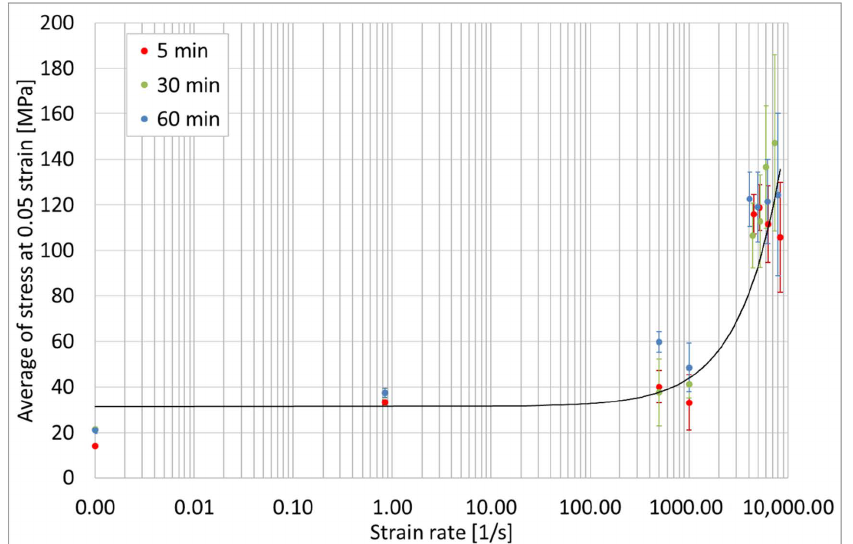
Figure 17. Statistical analysis of results for an average value of stress under a 0.05 strain vs. a strain rate.